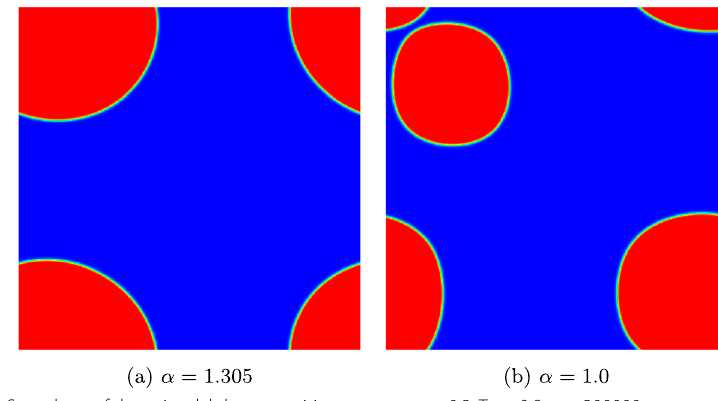
Fig. 18 Snapshots of the spinodal decomposition process, τ = 0.3 , T r = 0.8 , t = 200000